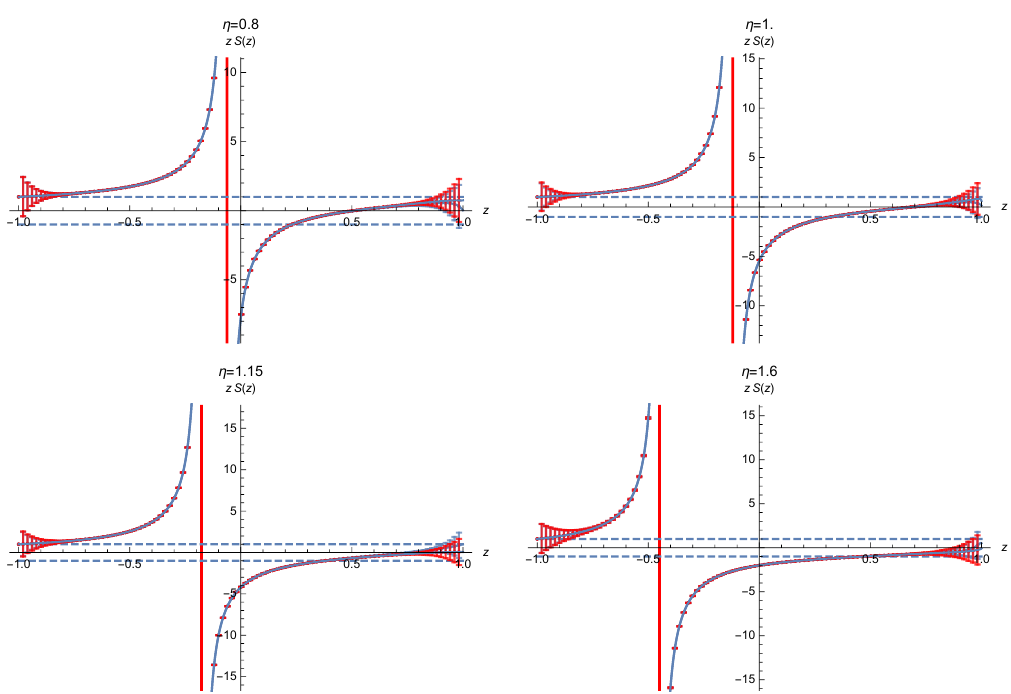
Figure 21. Error bounds on the numerical fitting of zS ( z ) computed using method II, with the assumption of extra complex resonance z 0